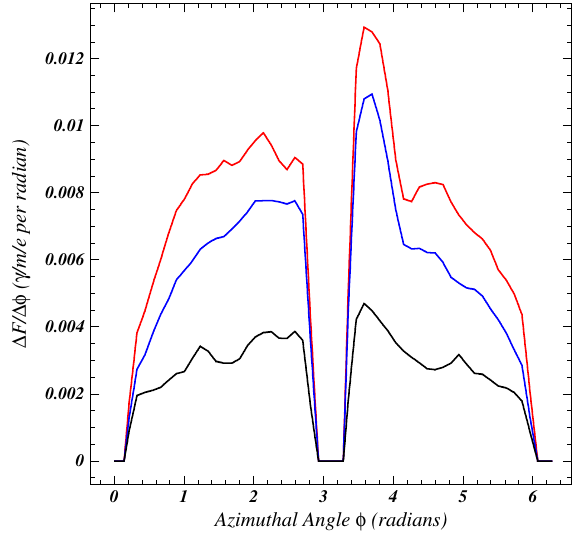
ð ϕ Þ versus azimu- FIG. 8. Absorbed photon rate per radian Δ F Δ ϕ thal angle ϕ in Arc 1 of the DR, averaged over the regions corresponding to three types of magnetic environment: (i) quadru- pole fields (red), (ii) fieldfree regions (blue), and (iii) dipole fields (black). The azimuthal angle ϕ is defined to be zero where the vacuum chamber intersects the bend plane on the outside of the ring. The angle π = 2 corresponds to the top of the vacuum chamber. The low photon rates at zero and π radians are due to the absorption in the